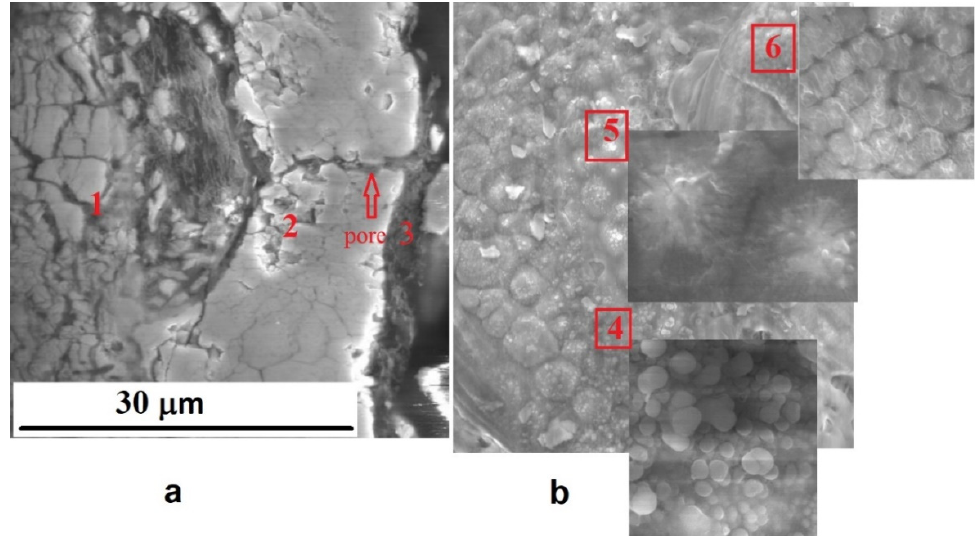
Figure 6. The cross-sectional microstructure ( a ) and surface morphology ( b ) of the PEO coating formed at a current density 40 A/dm 2 . 1—middle layer; 2—outer layer; 3—surface layer; 4—layer of Y 2 O 3 particles; 5—residual melted areas of the surface layer with fragments of yttria particles; 6— grains of zirconia and melted areas of the surface layer.